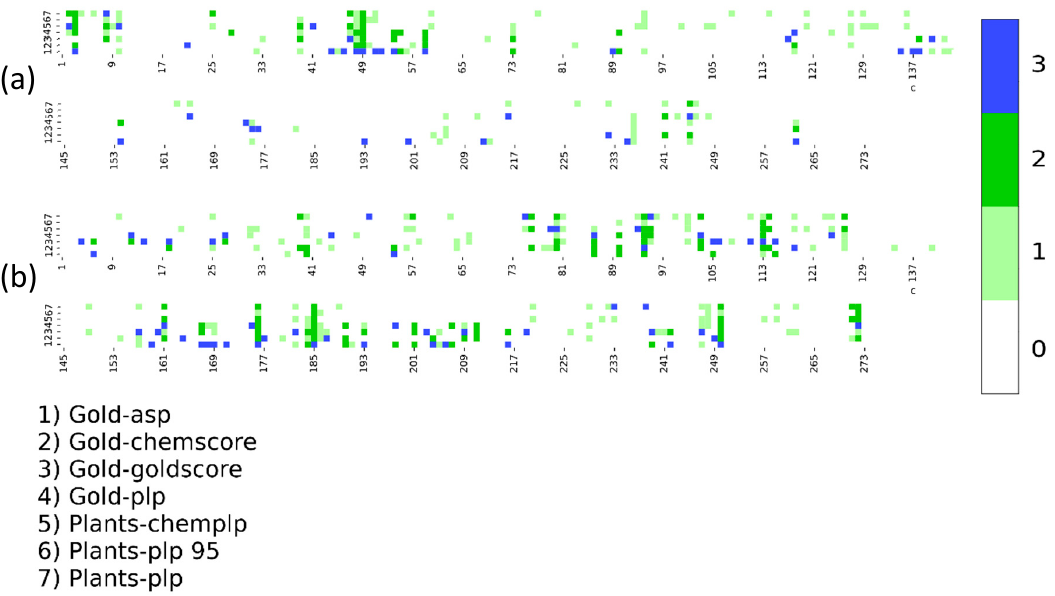
Figure 4. Comparison between DockBench Results in terms of Protocol Score for cluster PF00194 (carbonic anhydrases) with ( b ) and without ( a ) the Zinc ion.